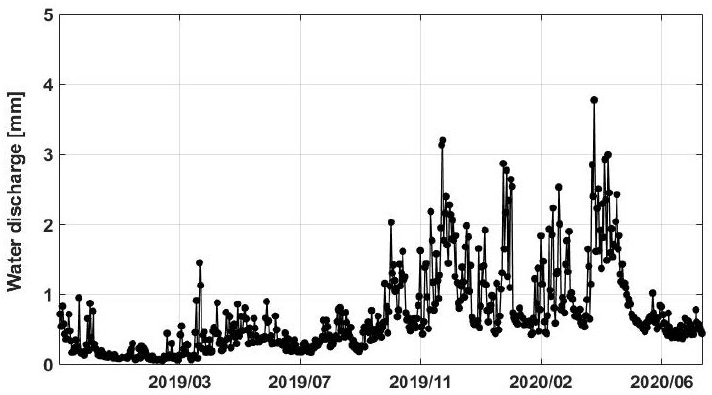
Figure 7. Average water discharge from the assimilation results over